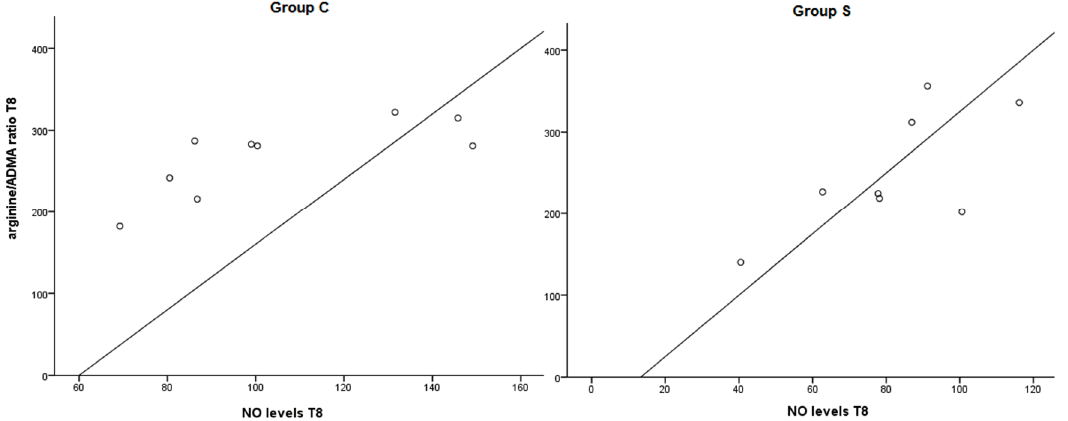
Figure 4. Pearson correlation between arginine/ADMA ratio T8 and NO levels at T8 in the statine ( n = 8) and control group ( n = 9) (S: r = 0.709, p = 0.049, C: r = 0.694, p =